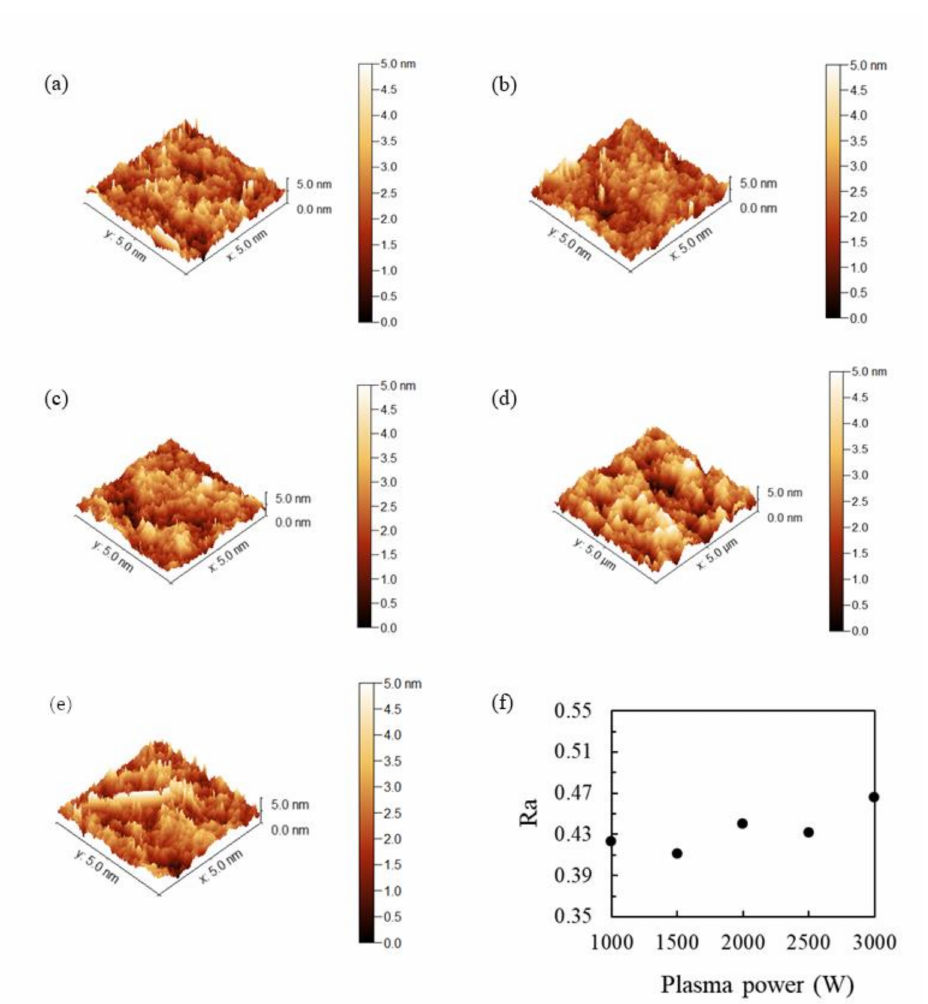
Figure 6. AFM images of the SiO 2 thin films with plasma power of ( a ) 1000 W, ( b ) 1500 W, ( c ) 2000 W, ( d ) 2500 W, and ( e ) 3000 W. ( f ) Ra values as a function of various plasma powers.